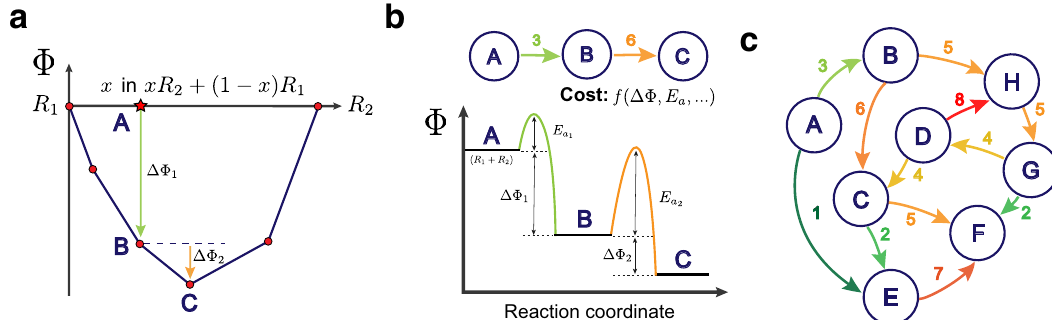
Fig. 1 Thermodynamic models of chemical reactions in increasing degree of abstraction. The label, A , indicates a combination of arbitrary amounts of phases R 1 and R 2 . Similarly, the other labels ( B – F ) are combinations of arbitrary amounts of other phases that result from the chemical reactions. a The convex hull construction for consecutive reactions between two reactants, R 1 and R 2 . The points drawn indicate sets of chemical reaction products at different stoichiometric mixtures of the reactants, and the lines trace the convex hull indicating the thermodynamic equilibrium (minimum free energy) for all ratios of mixing, x . b A traditional reaction coordinate diagram used to represent both the free energies of reaction, ΔΦ , and activation energies, E a . This is generalized by a weighted, directed graph connecting the three states (top). The cost/weight of the directed edges, shown as the colored number adjacent to each edge, is some function of the free energy change, activation energy, and other reaction features. c A chemical reaction network, which links together many such possible reaction pathways within a given set